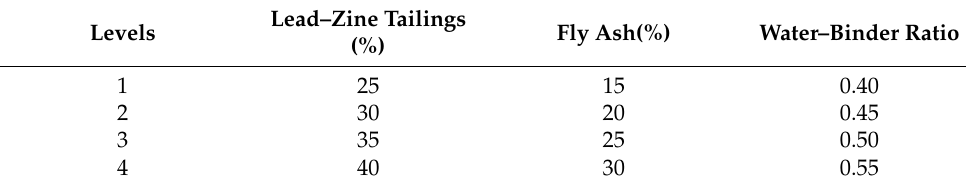
Table 5. Orthogonal test factors and levels.